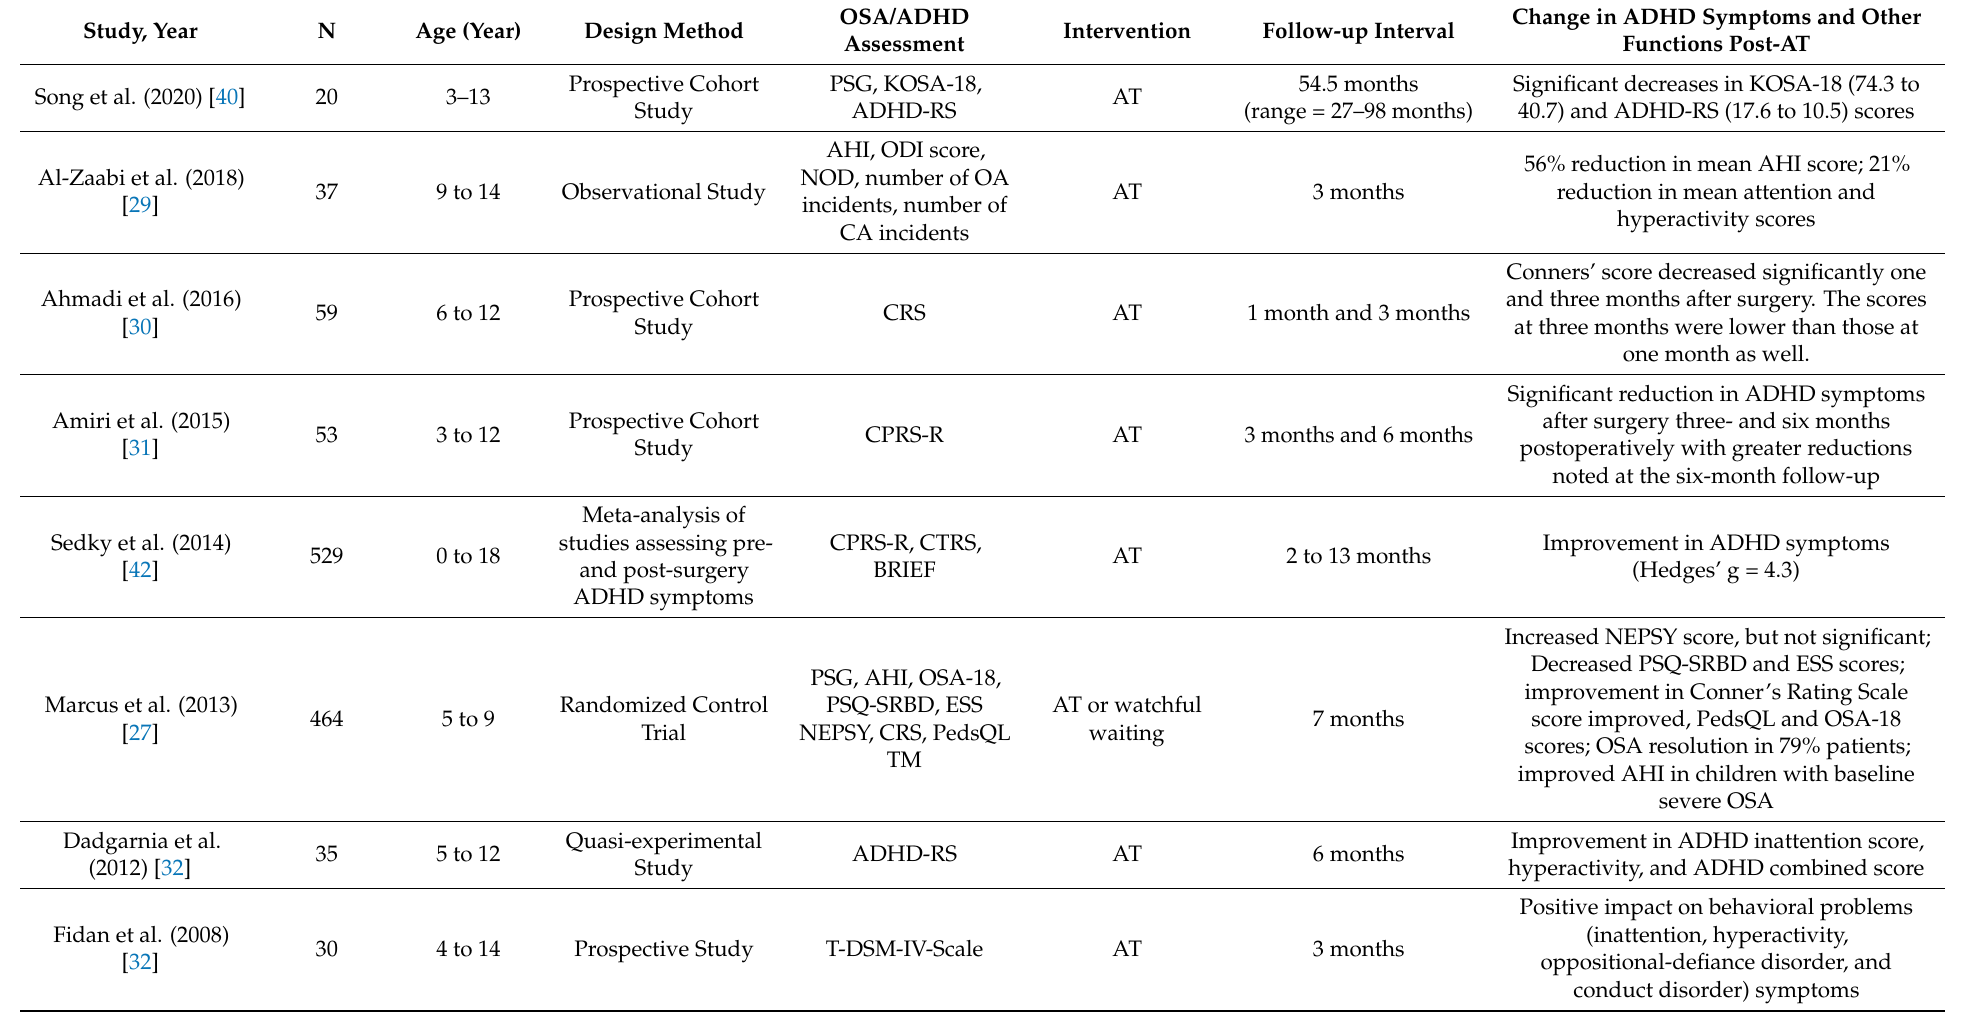
Table 1. Changes in ADHD Symptoms Post-Adenotonsillectomy in Studies of Obstructive Sleep